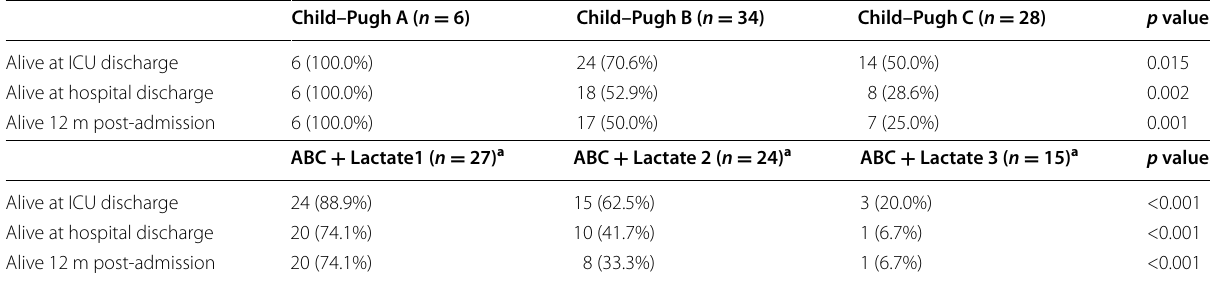
Table 5 Comparison of cumulative survival by Child–Pugh class and CLIF-SOFA organ failure grade in 68 cirrhotic patients admitted to a general